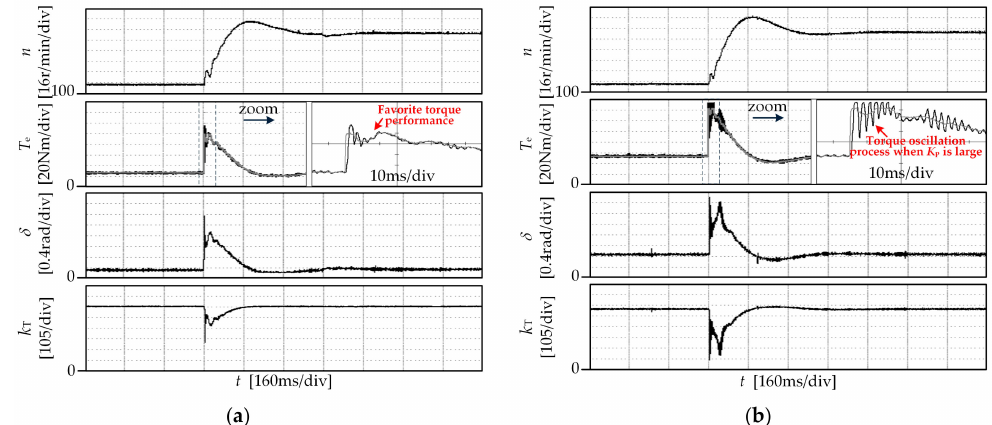
Figure 12. Experimental waveforms of the conventional DTC-SVM scheme during transient operation at K p = 6.25 × 10 − 4 ; T i = 20 T s . ( a ) No load; ( b ) 50 Nm load.